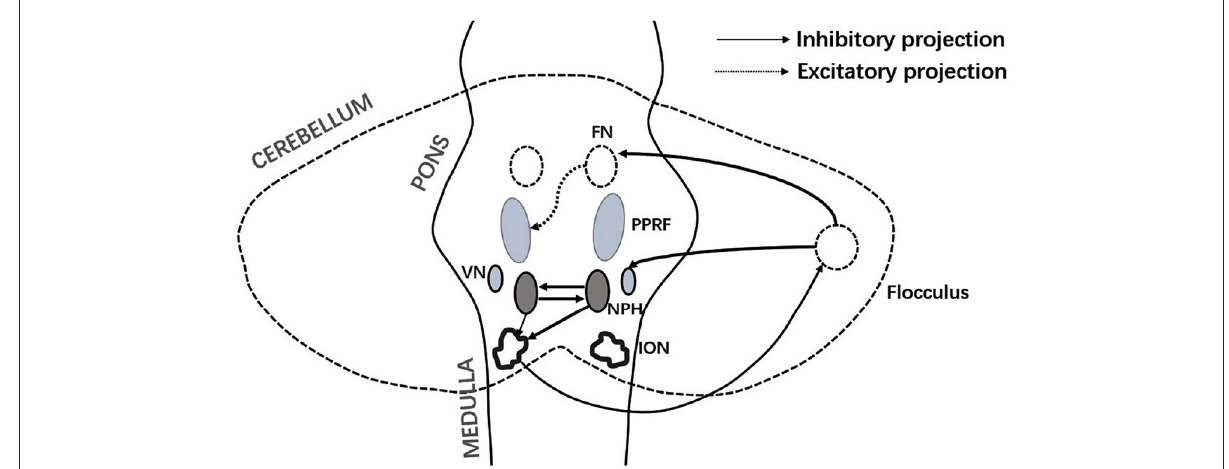
FIGURE4 Connections between the NPH and vestibular-brainstem-cerebellar system. FN, fastigial nucleus; VN, vestibular nucleus; NPH, nucleus prepositus hypoglossal; PPRF, paramedian pontine reticular formation; and ION, inferior olivary nucleus. The ION principally accepts inhibitory fibers from the contralateral NPH. Damage to one side of the NPH excites the contralateral Purkinje fibers. The contralateral VN and cerebellar fastigial nucleus are suppressed, and the excitability of the contralateral PPRF